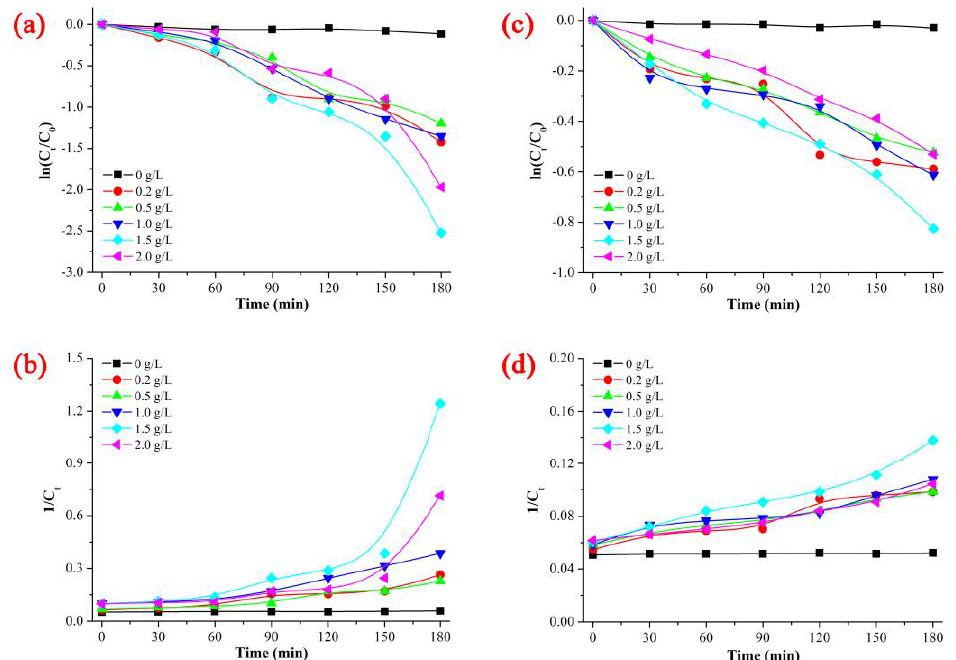
Figure 7. Pseudo-first-order kinetics model and pseudo-second-order kinetics model of MO ( a , b ) and PNP ( c , d ) using ZnO NPs. Table 2. Pseudo-first-order and pseudo-second-order kinetics of MO and PNP using ZnO NPs. ZnO NPs Pollutant